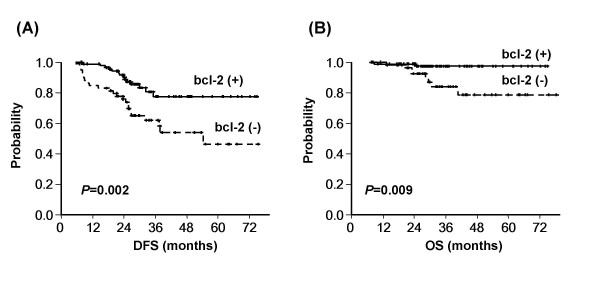
Kaplan-Meier plots of (A) disease-free and (B) overall survival according to bcl-2 expression. The expression of bcl-2 was found to be significantly and positively associated with disease-free and overall survivals.